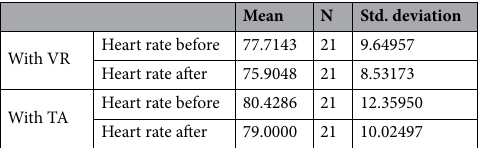
Mean N Std. deviation